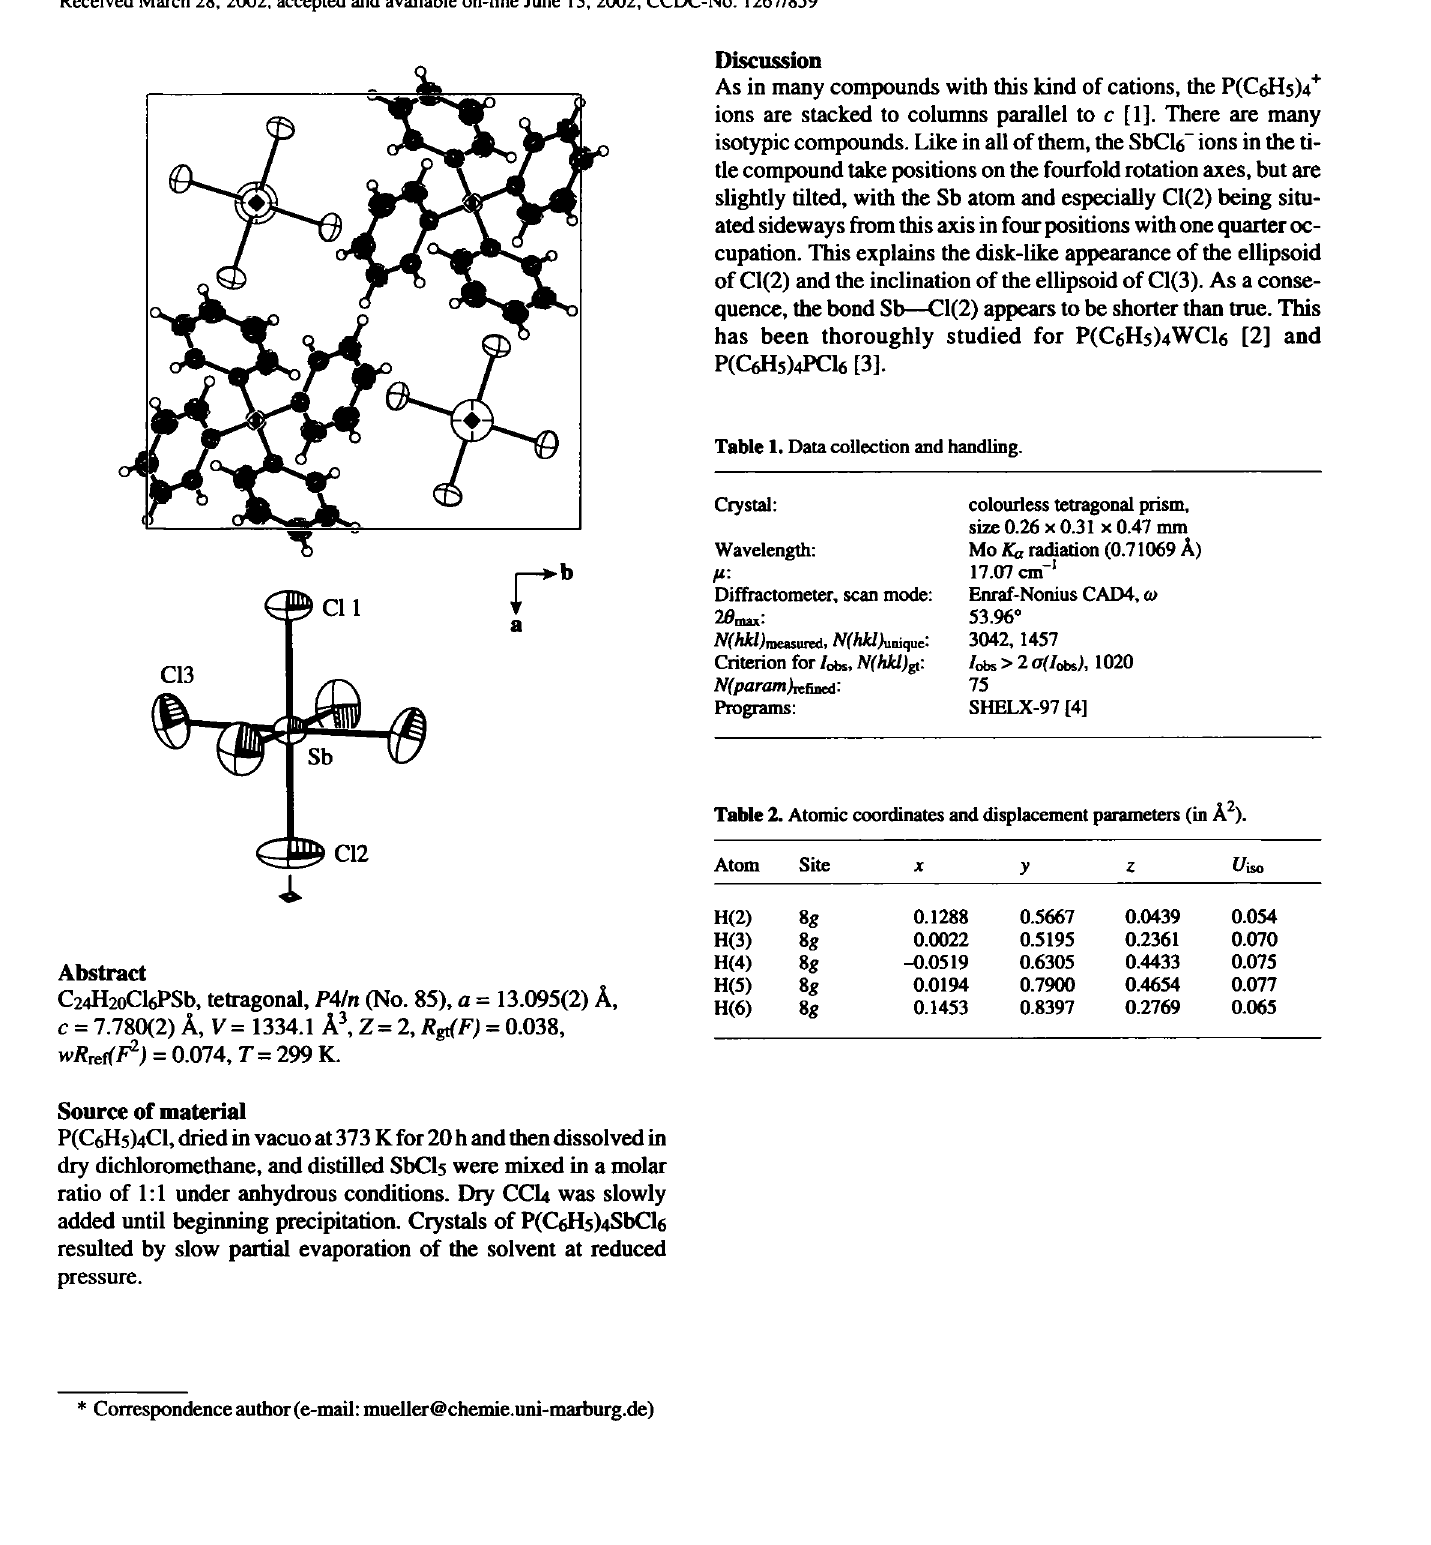
Table 1. Data collection and handling.